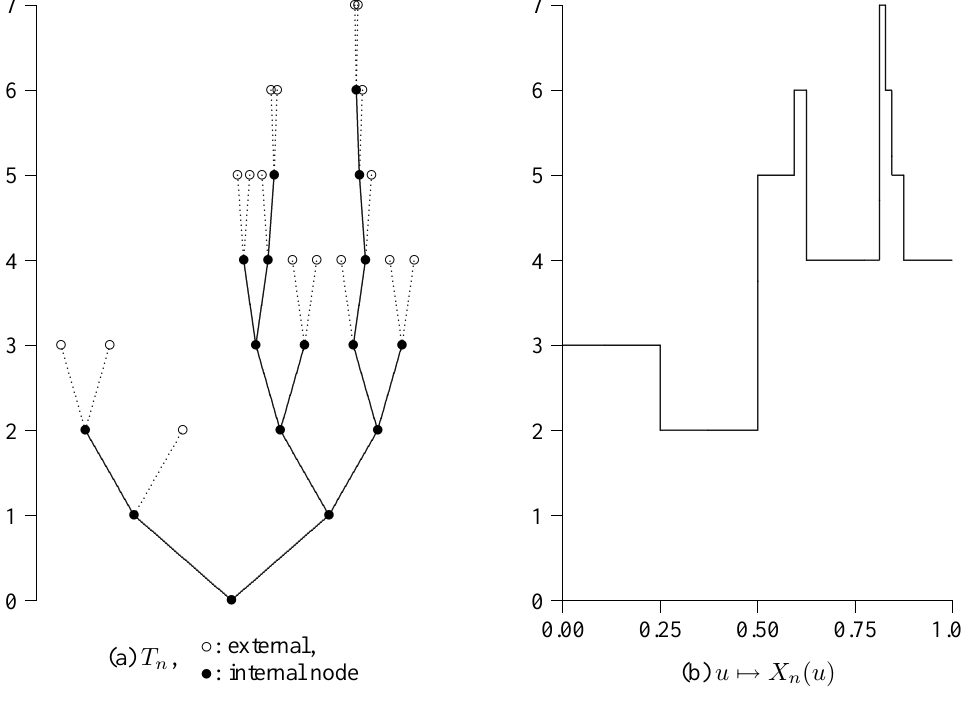
Fig. 1: A binary tree and its